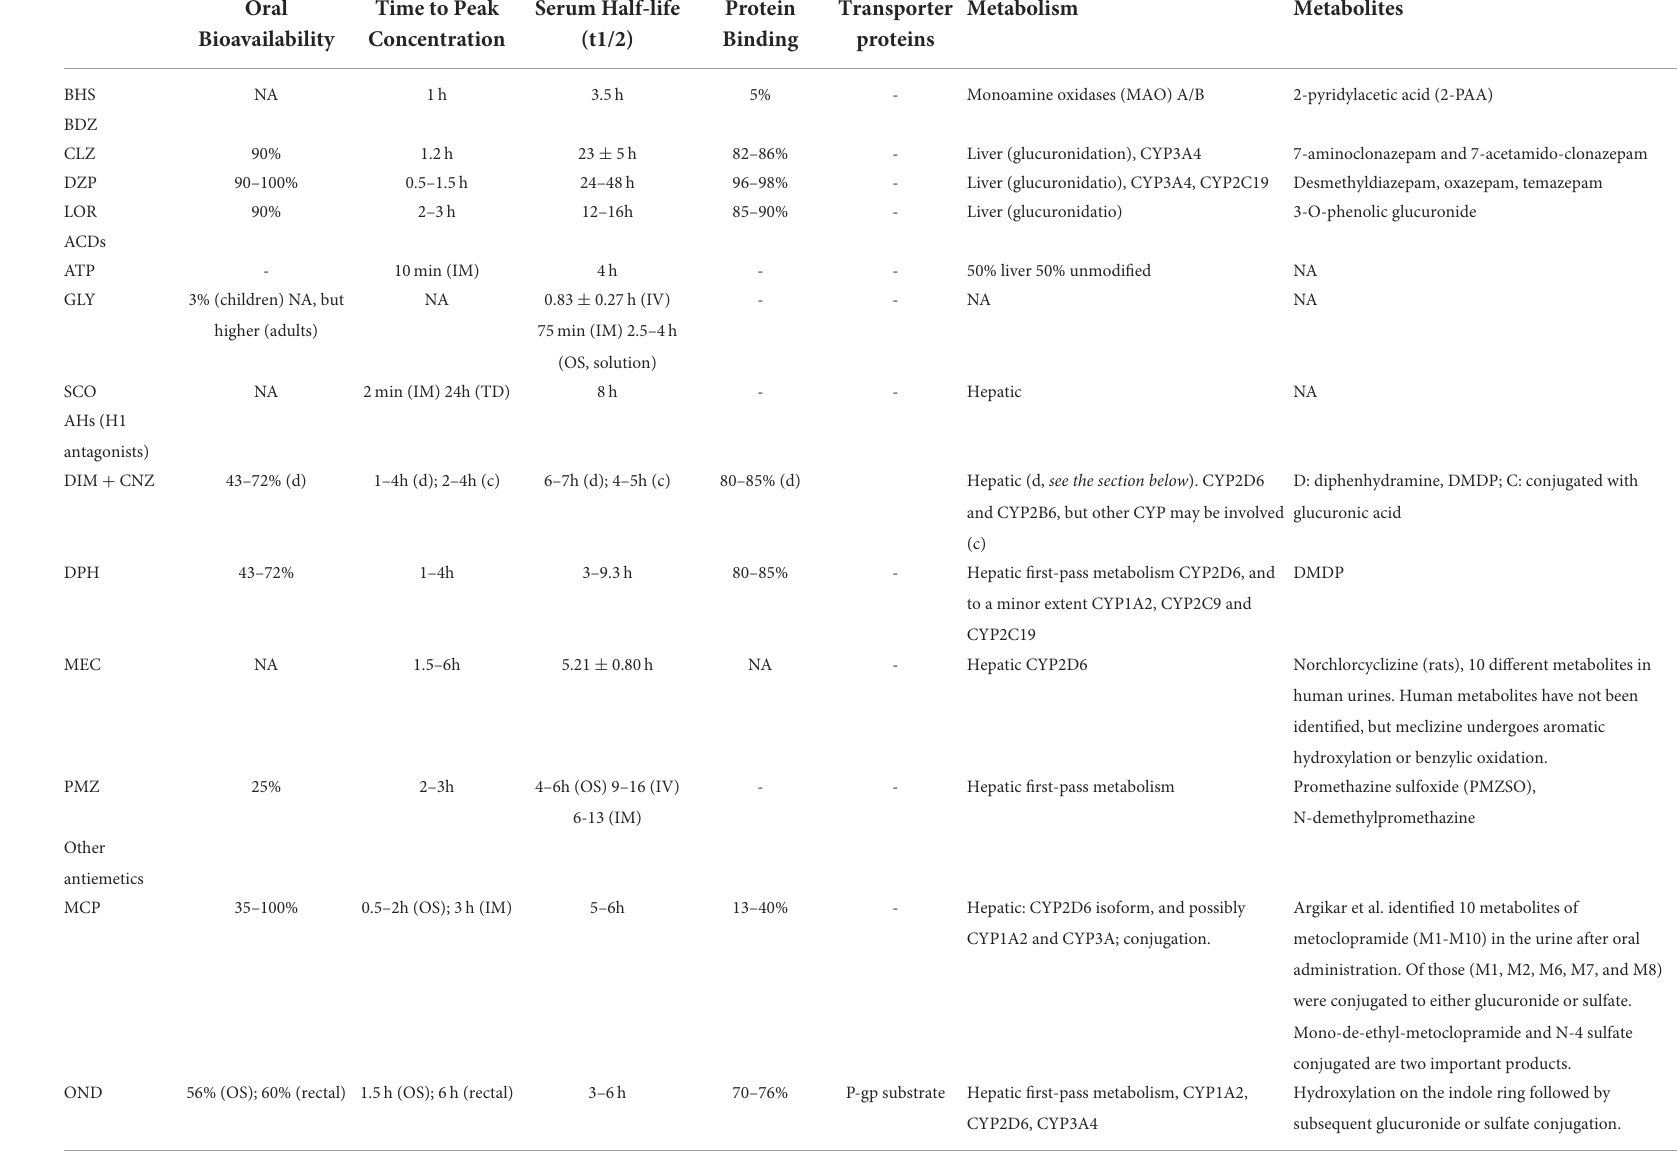
TABLE 2 Pharmacokinetics of drugs used in peripheral vestibular vertigo (part